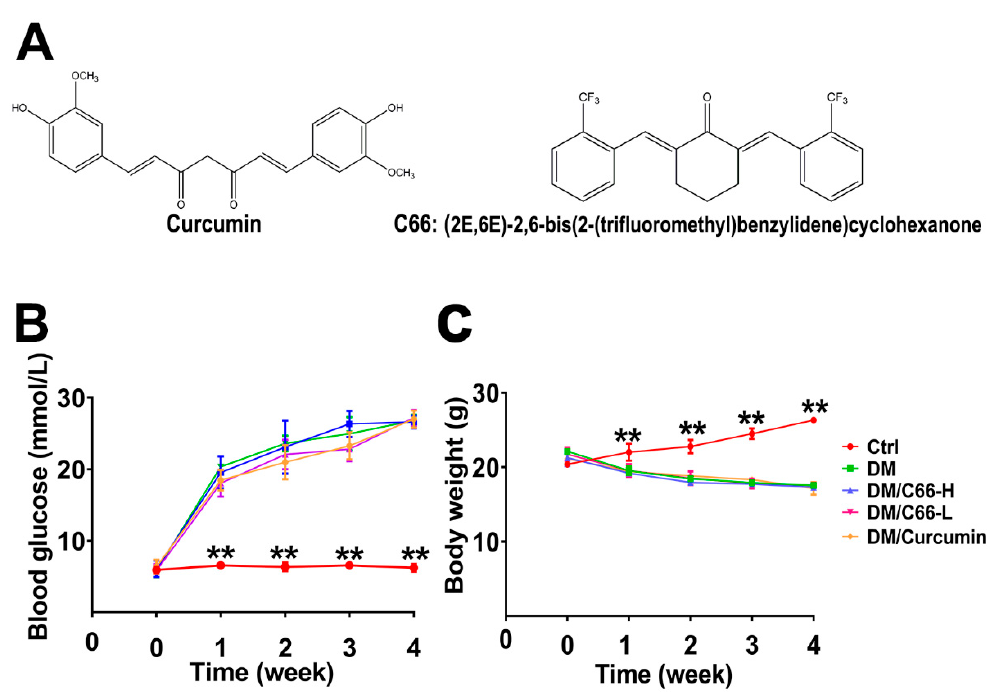
Figure 1. Establishment of streptozotocin (STZ)-induced diabetic mice. The mice with blood glucose greater than 16.7 mmol/L were defined as diabetic mice. ( A ) Chemical structures of curcumin and C66. Blood glucose levels ( B ) were monitored during the study period. Body weight ( C ) was significantly decreased in the diabetic group and C66 treatment group compared with the control group. The data are expressed as the means ± S.D. ( n = 6 per group, ** p < 0.01 compared to the control value). DM and Ctrl are short for the diabetic and control group, respectively.